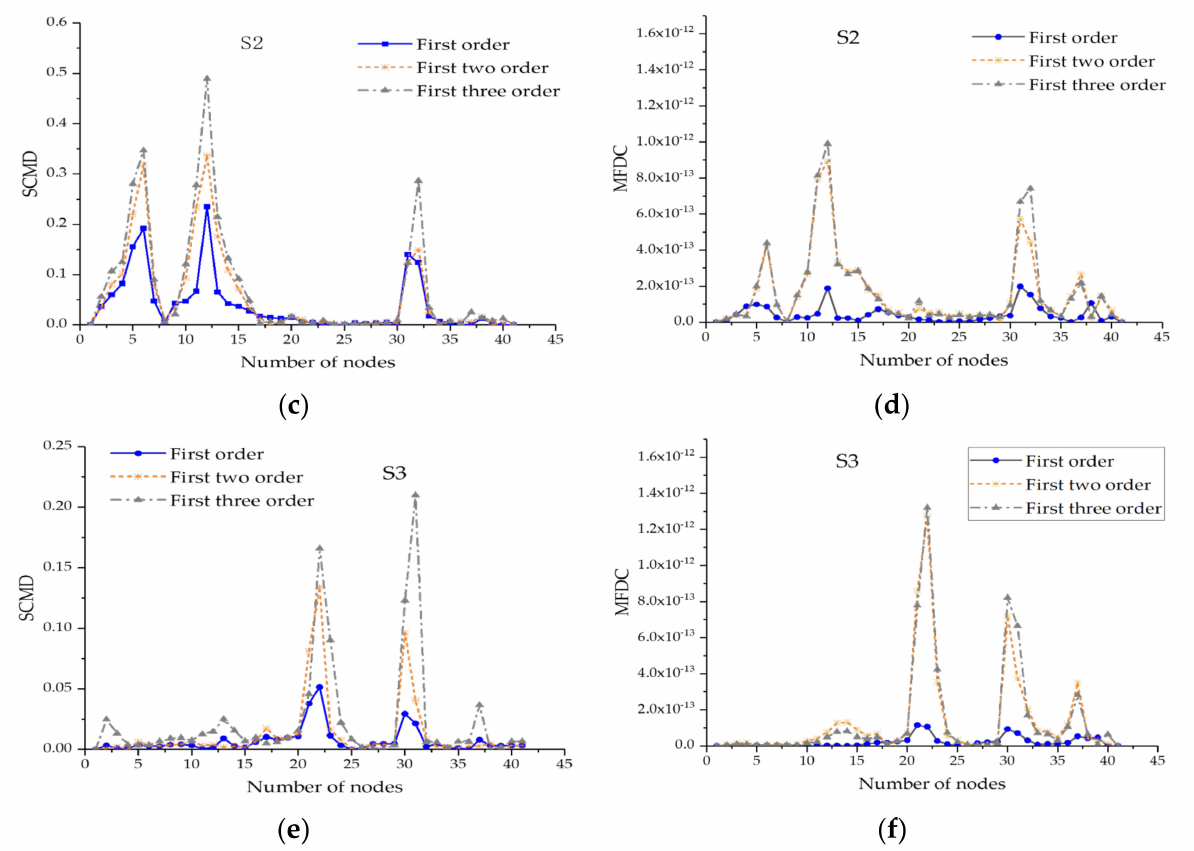
Figure 7. Results of the single index damage identification. ( a ) Damage condition S1,